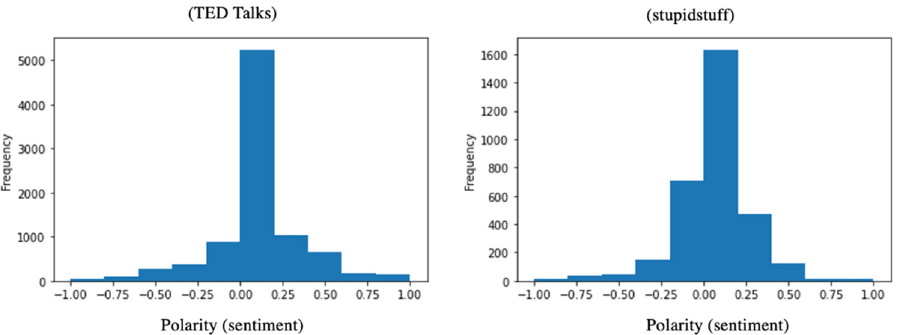
Figure 8. Histogram of sentiment for humorous sentences in TED Talks ( left ) and jokes from stupidstuff.org ( right ).